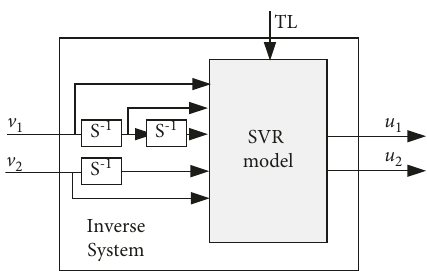
Figure 4: Inverse system modeling of SVR.